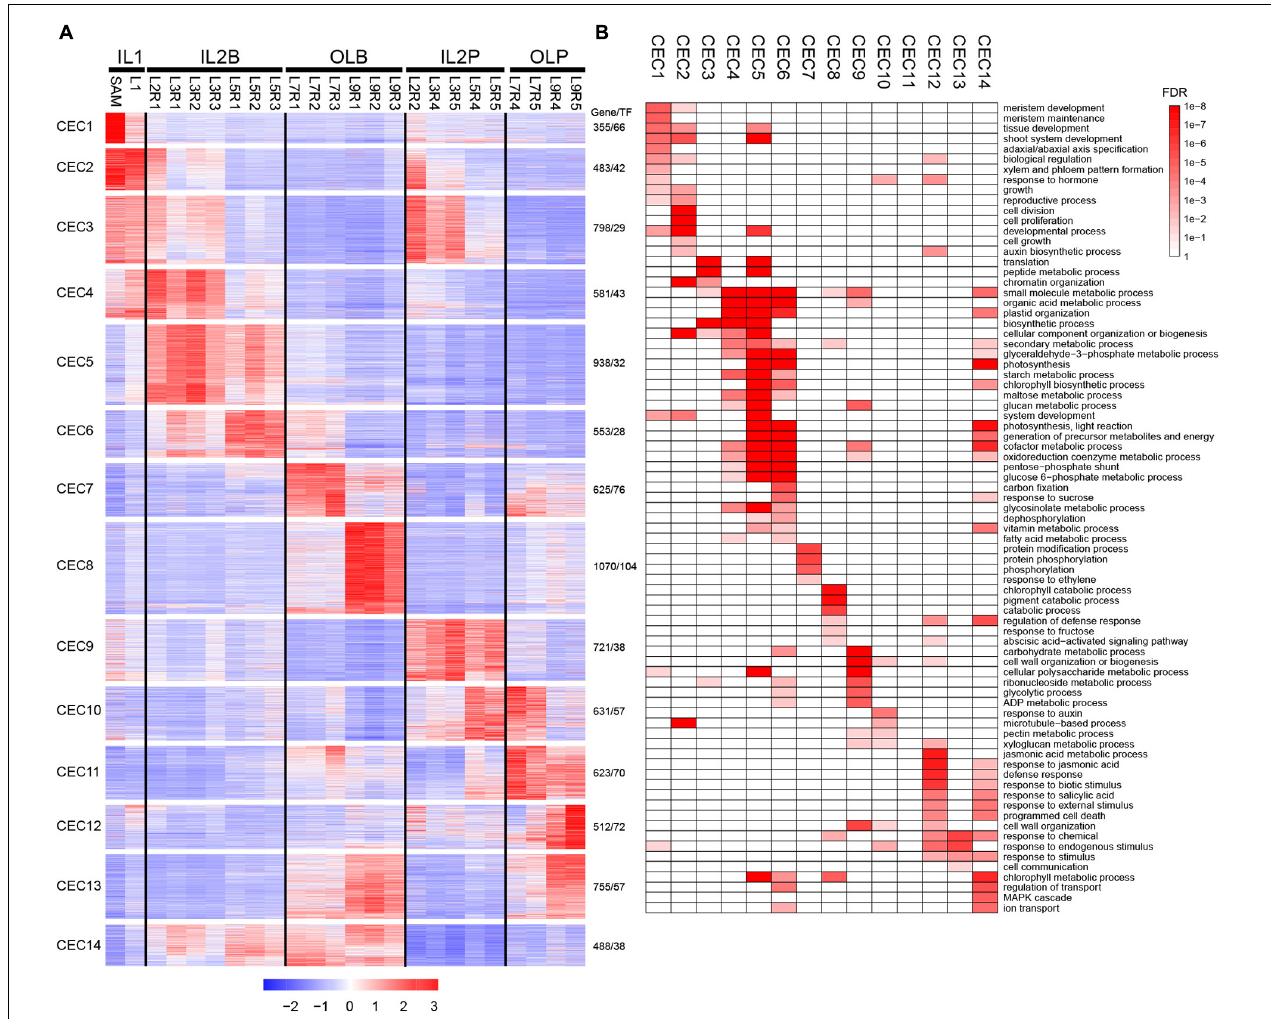
FIGURE 2 | Expression profiles and functional transition of 9,133 DEGs in different leaves. (A) K-means clustering of DEGs. A total of 9,133 DEGs were grouped into 14 clusters. For each gene, expression data were Z-score standardized. (B) Gene ontology (GO) slim categories of each co-expressed cluster were presented as a heatmap with a color gradient based on the false discovery rate (FDR) values. Only significant GO categories (FDR < 0.05) were